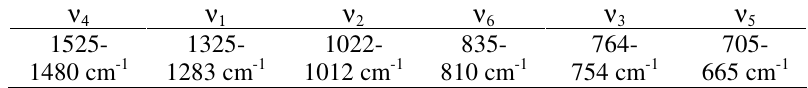
Table 4. Infrared absorption frequencies (cm -1 ) of nitrato groups of lanthanide(III) nitrate